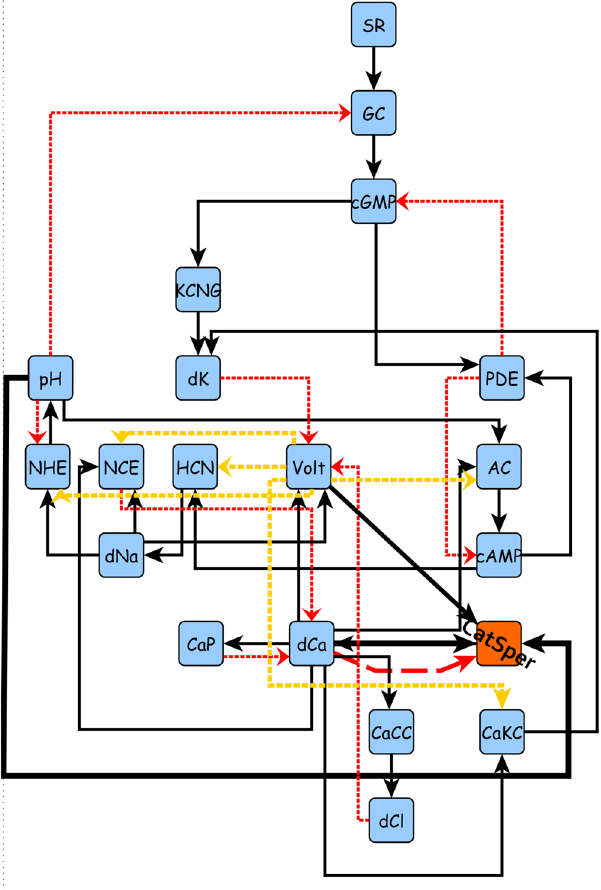
Figure 3. Network representation of the signaling pathway with CatSper channel as the only source of intracellular Ca 2 + concentration. Notice the absence of the LVA and HVA channels previously depicted in Fig. 1. Also note the new direct link between pH, voltage and Ca 2 + node with the CatSper channel, highlighted with bold arrows. This network constitutes